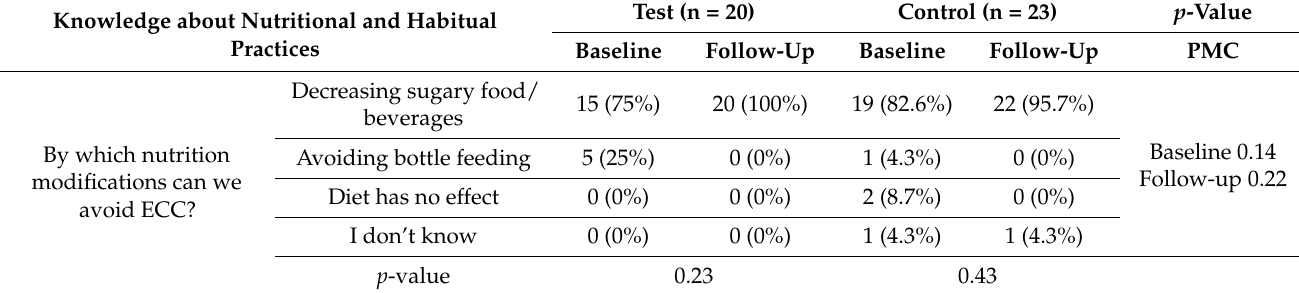
Table 5. Knowledge about nutritional and habitual practices at baseline and